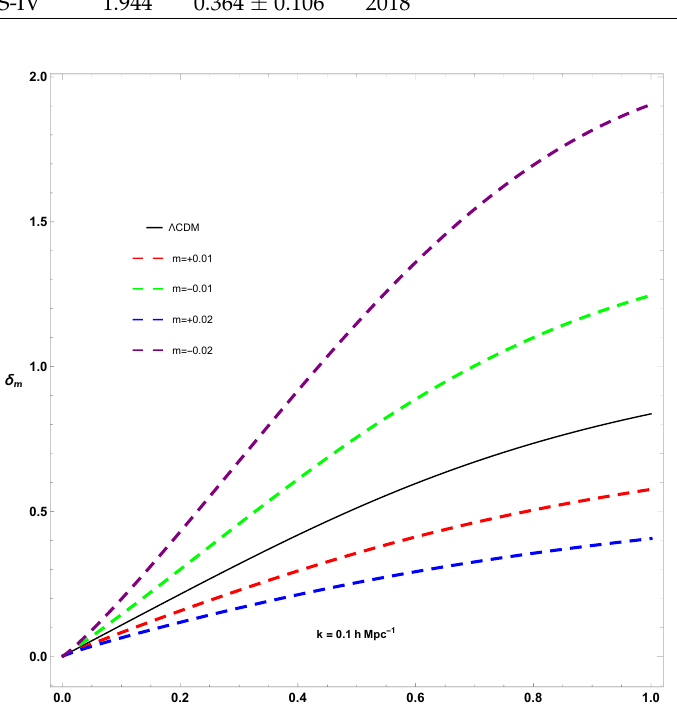
Figure 4. Matter growth for various values of the parameter m with α = β = µ = ν = c 2 ε =